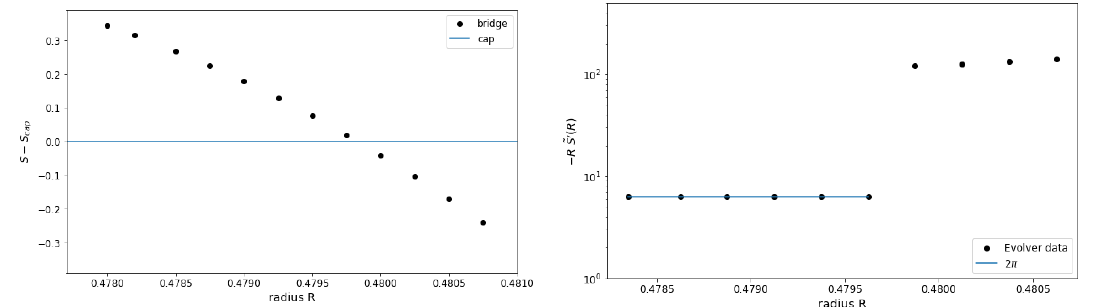
Figure 7. Left: The black data points show the area difference between the bridge surface and the cap surface at the same R. Right: The derivative of the EE is discontinuous across the transition from cap to bridge